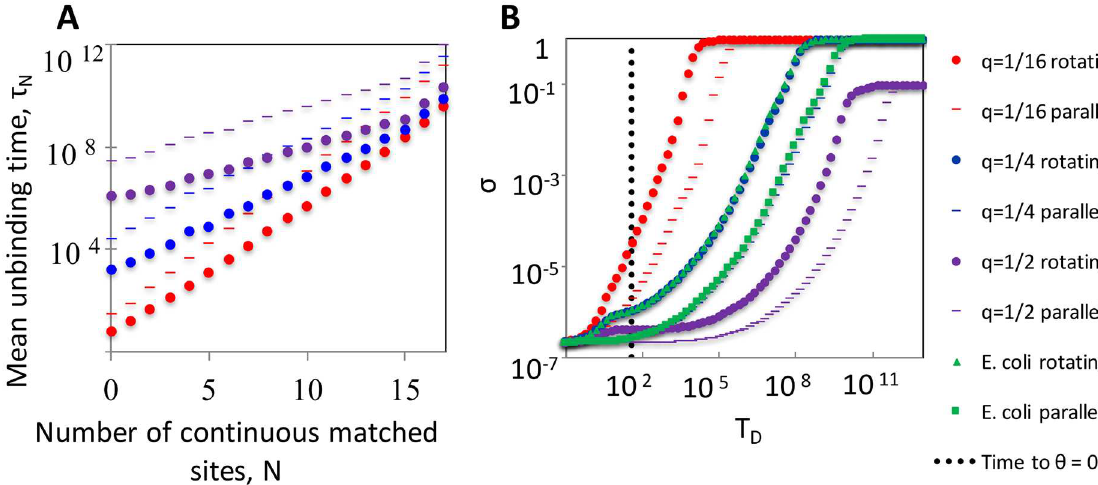
Fig 3. Rotational fluctuations mitigate kinetic trapping. (A) Mean unbindingtime for pairs of rods with N continuous matched sites about the center. We consider both rotating rods that begin at θ 0 = 0, and constrained parallelrods that are allowedto unbind but not rotate. Three accidentalmatch probabilities are considered for sites beyond N . All times in this figure are measuredin units in which the rate of unbindingequals 1. (B) The specificity σ as a function of the delay time betweencollisionand irreversible binding.The mean time requiredfor a homologouspairing(with q = 1/4) to rotate to parallelalignment is marked reference (dashed